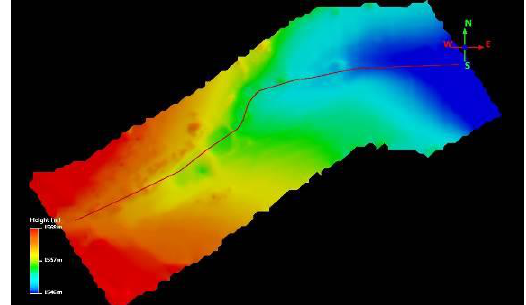
Figure 12. Slope path used for computation of slope